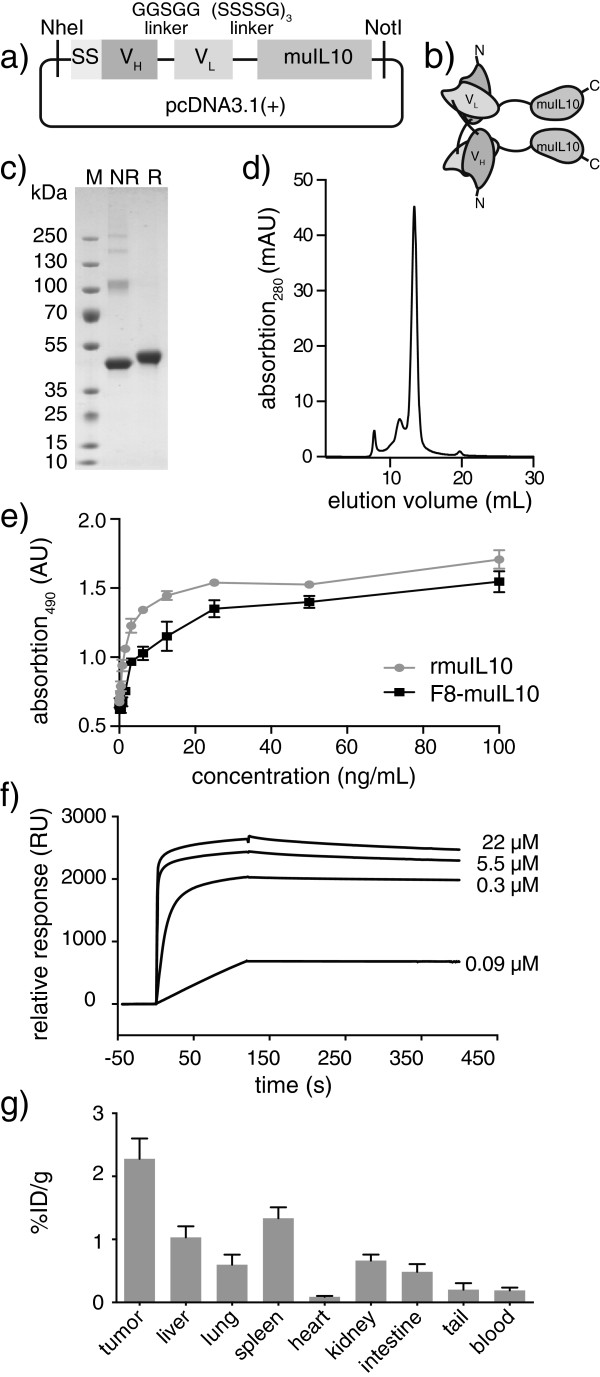
Cloning, expression and in vitro characterization of F8-muIL10. (a) Schematic representation of the cloning strategy of F8-muIL10. The murine IL-10 moiety was fused by a 15-amino-acid linker (SSSSG)3 to the C-terminus of the F8 scFv antibody fragment in diabody format (five-amino-acid linker between variable heavy chain (VH) and variable light chain (VL)). SS, signal sequence. (b) Schematic representation of protein domain assembly of the noncovalent F8-muIL10 dimer. (c) SDS-PAGE analysis of purified F8-muIL10. M, molecular weight marker; NR, nonreducing conditions; R, reducing conditions. (d) Size exclusion chromatography (SEC200) of noncovalent homodimeric F8-muIL10. (e) MC/9 cell proliferation assay. F8-muIL10 and recombinant murine IL10 induced proliferation of MC/9 cells (mean ± standard deviation (SD), n = 3). (f) BIAcore analysis of F8-muIL10 on extra-domain A of fibronectin (EDA)-coated chip. (g) Quantitative biodistribution study of radioiodinated F8-muIL10. Mice bearing subcutaneous F9 tumors were injected intravenously with 15 μg radiolabeled protein (n = 3). Mice were sacrificed after 24 hours and organs were excised and radioactivity counted, expressing results as percent of injected dose per gram of tissue (%ID/g ± SD).